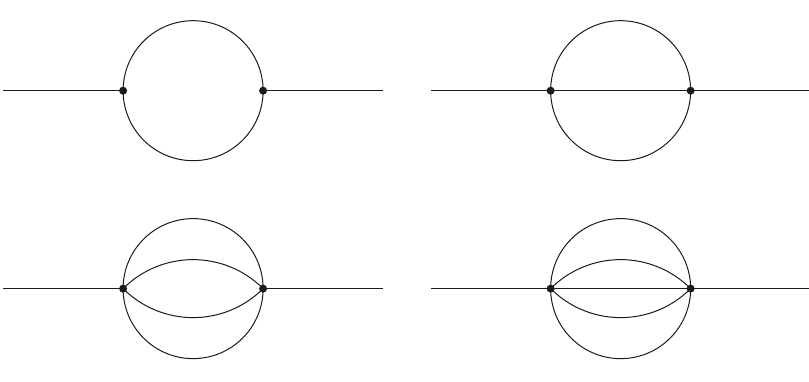
Figure 1 . The graphs for the banana integrals from one to four